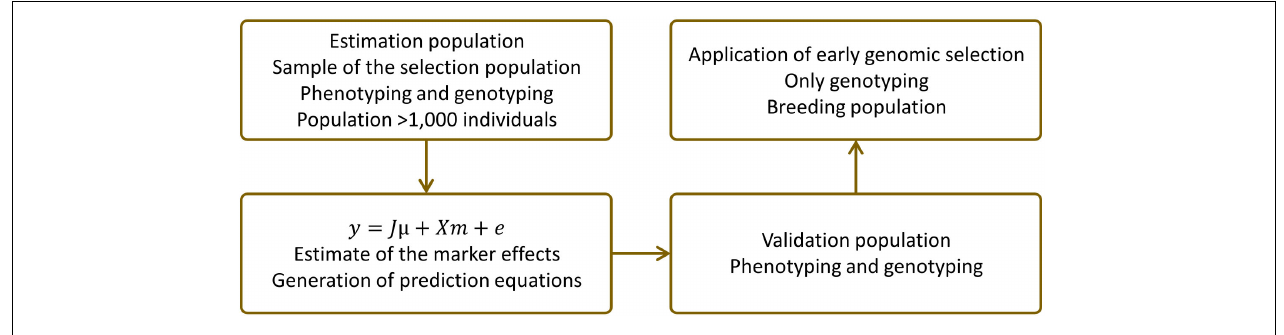
FIGURE 3 | Schematic application of genomic selection (GS) in a genetic improvement program (Resende et al., 2012).